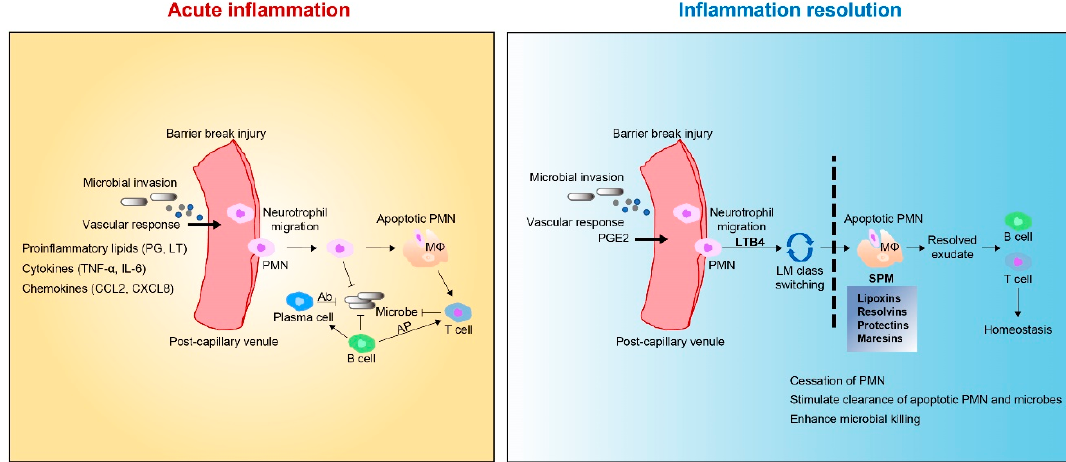
Figure 2. The outcome of acute inflammation and resolution. Under stimulation of injury or infection, release of proinflammatory lipids (prostaglandin (PG), leukotriene (LT)), chemokines (C-C motif chemokine ligand 2 (CCL2), C-X-C motif ligand 8 (CXCL8)), and cytokines (tumor necrosis factor- α (TNF- α ), interleukin (IL)-6) induce the recruitment of neutrophils. Other immune cells (macrophages, B cells, and T cells) also participate in the process. Macrophages directly phagocytize organisms and apoptotic neutrophils, while B cells are converted into plasma cells to kill organisms through secreted antibodies, referred to as antibody-dependent cell-mediated cytotoxicity. Macrophages and B cells activate T cells via antigen cross presentation (AP). PGE2 leads to vasodilation and LTB4 stimulates PMN influx into the inflammatory locus. Subsequently, lipid mediator (LM) class switching converts proinflammatory signals into pro-resolving signals and triggers resolution. SPMs restrict excessive PMN influx to the injury site, enhance efferocytosis, and stimulate pro-resolving signals. 4.